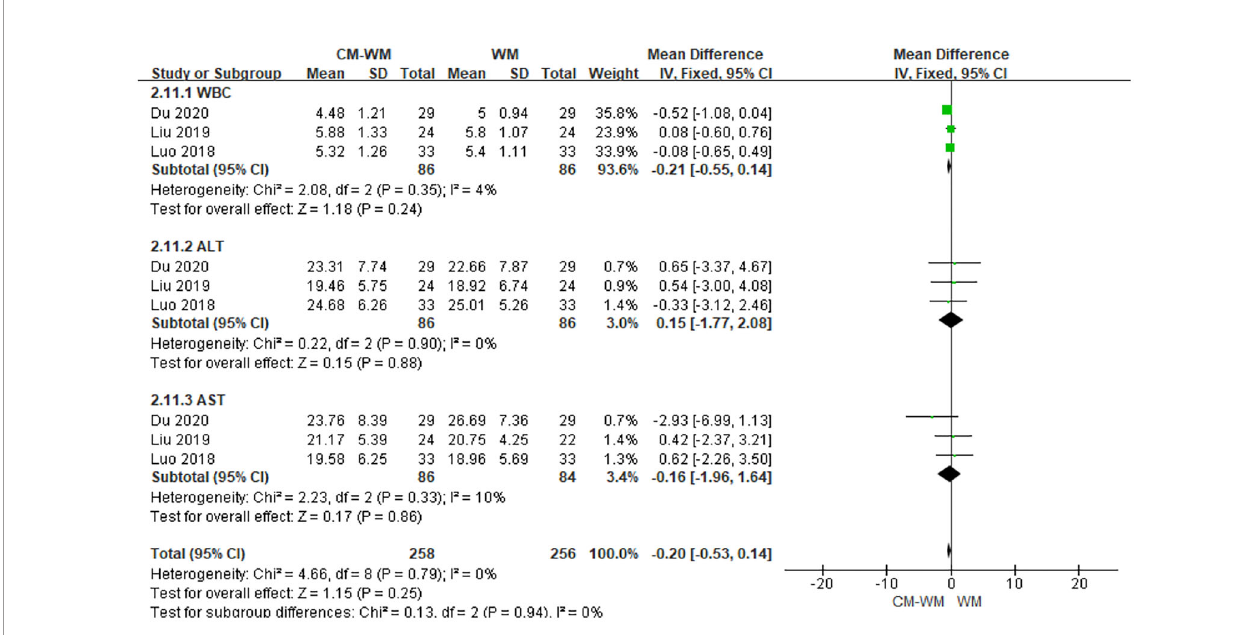
FIGURE 18 | Meta-analyses on safety